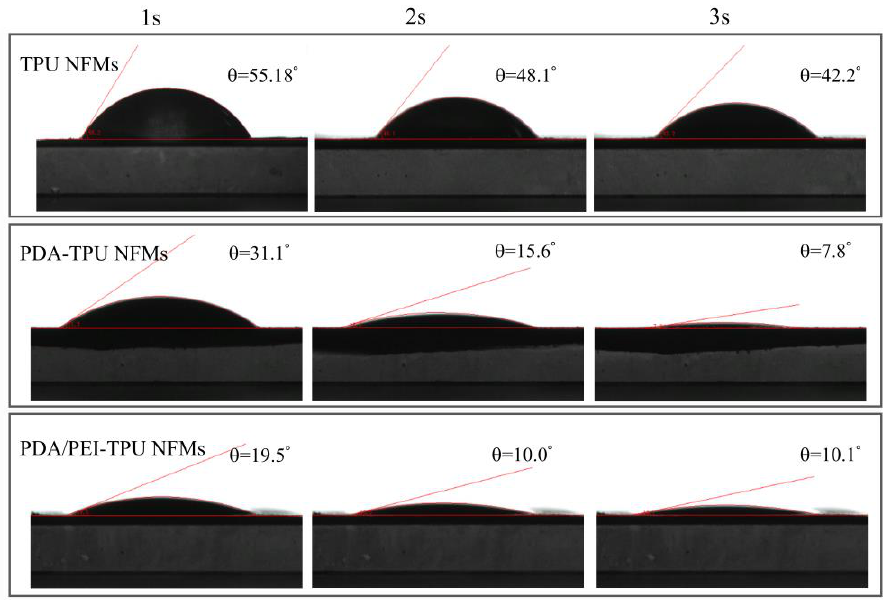
Figure 6. The contact angle of ( a ) TPU NFMs, ( b ) PDA-TPU NFMs and ( c ) PDA/PEI-TPU NFMs.